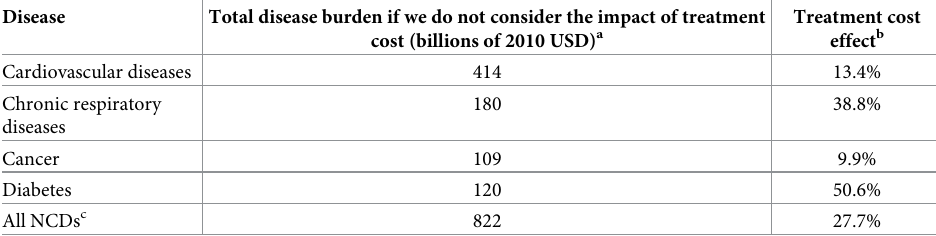
Table 3. Economic burden due to the four NCDs and all NCDs associated with air pollution, excluding treatment cost effect in China, 1990–2030.